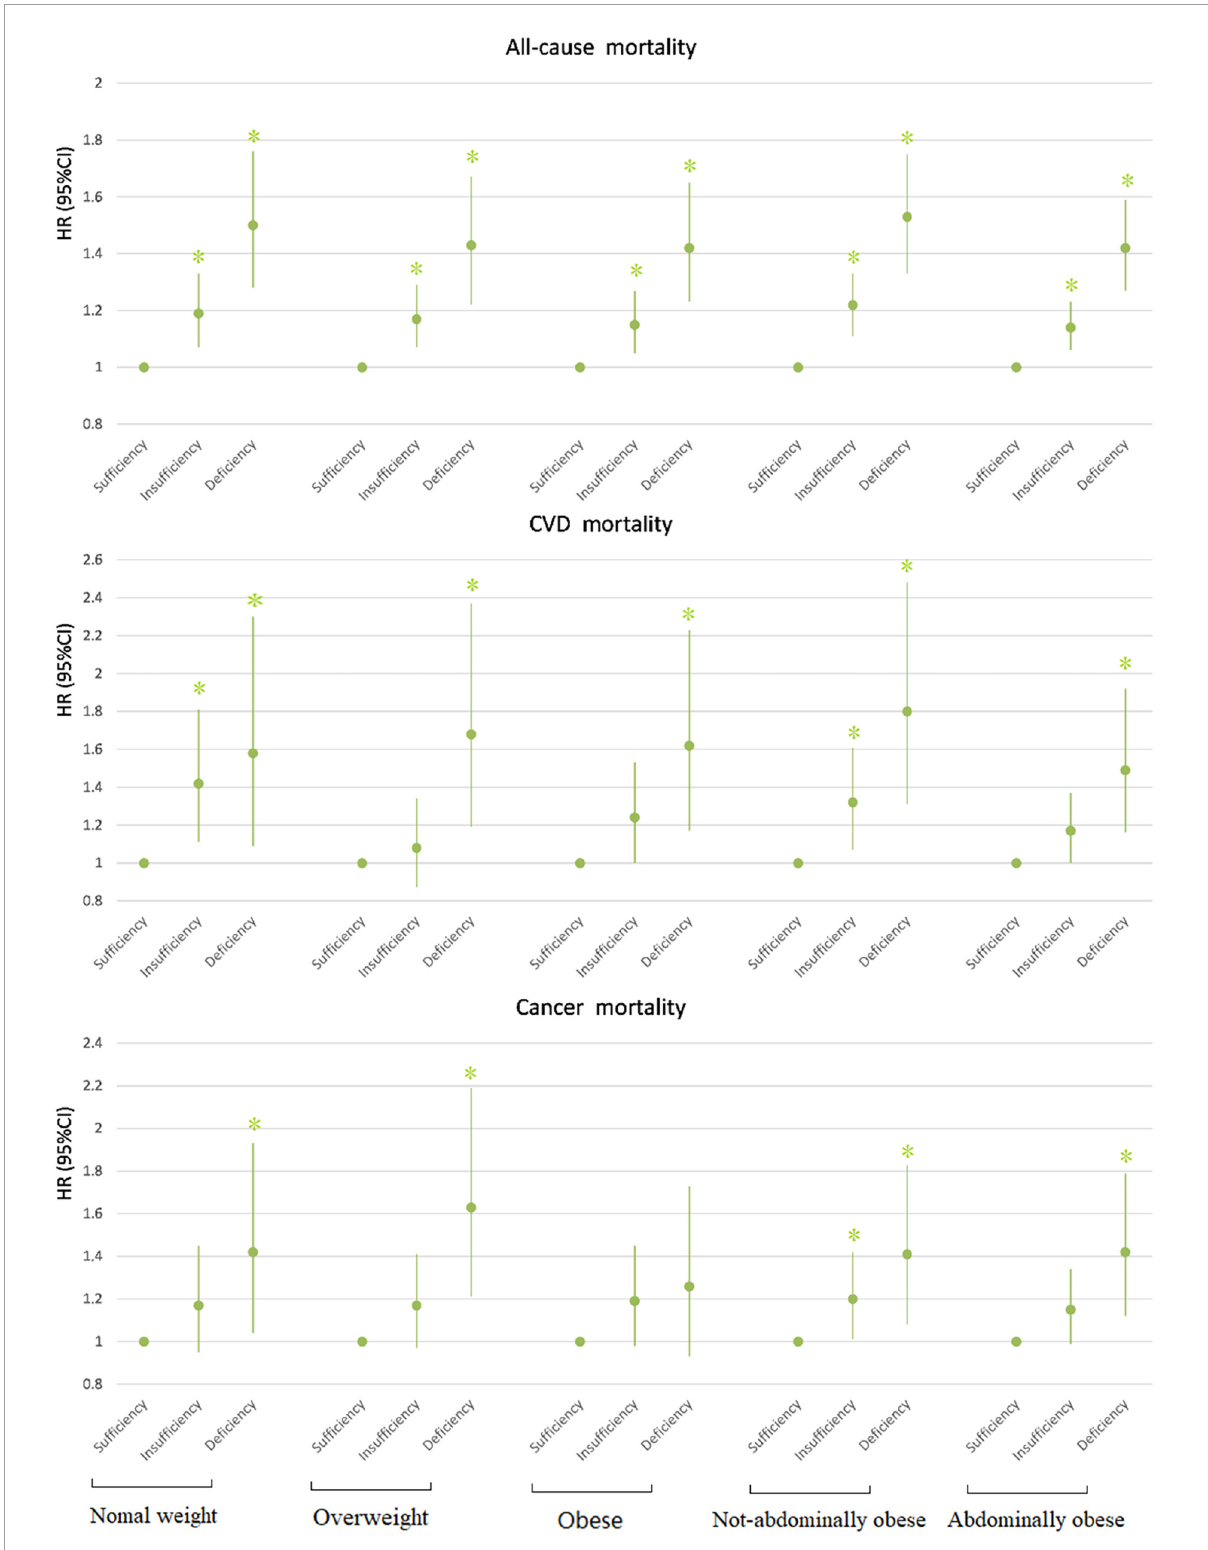
FIGURE1 Association between 25(OH)D concentration and mortality by BMI/WC. All models adjusted for age, race, gender, educational level, ratio of family income to poverty, leisure-time physical activity, smoking, and drinking. ∗ P < 0.05. HR, hazard ratio; CI, confidence interval; CVD, cardiovascular